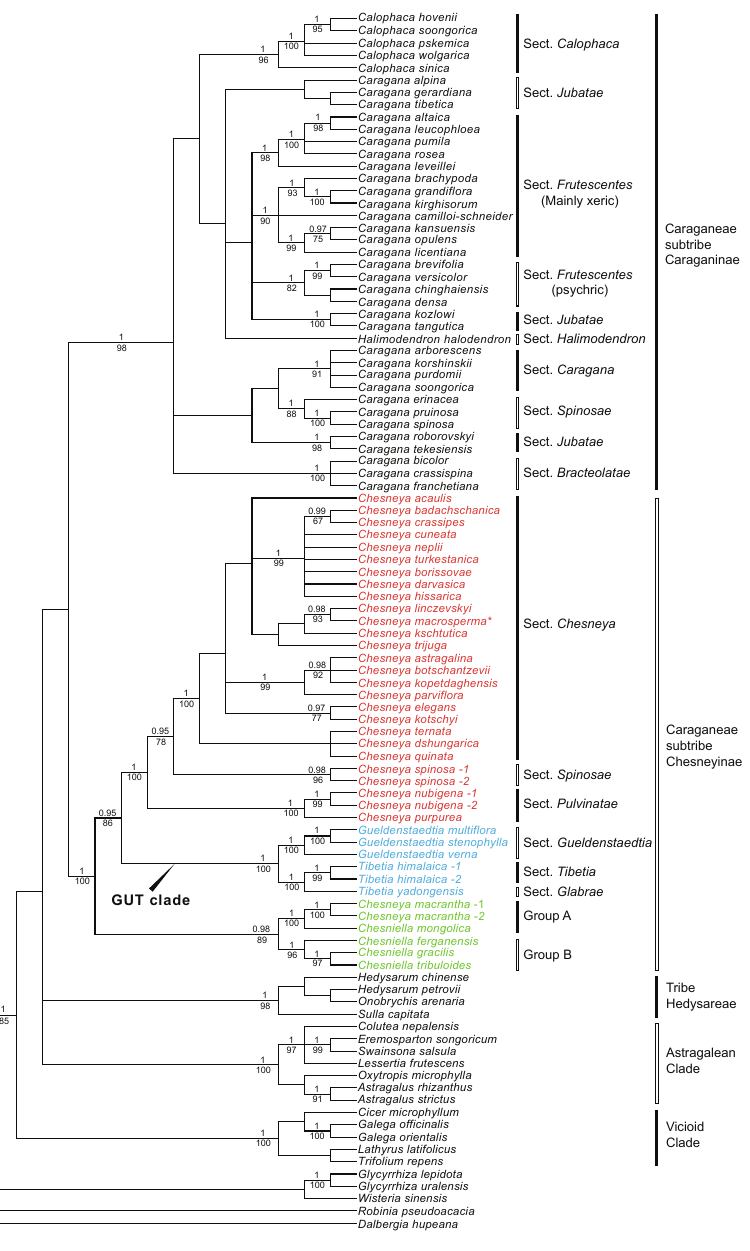
Figure 1. Bayesian tree of the nrDNA ITS data, showing relationships of genera in subtribes Caragani- nae, Chesneyinae and their close relatives. The labeled sections of Gueldenstaedtia and Tibetia followed Tsui (1979) and Zhu (2005a), respectively. Bayesian posterior probabilities (PP ≥ 0.95) and maximum likelihood bootstrap (LBS ≥ 70%) are given above and below branches, respectively. The asterisk indicates the name of Chesneya macrosperma has not been published, its voucher was storied in LE (details see Zhang et al.